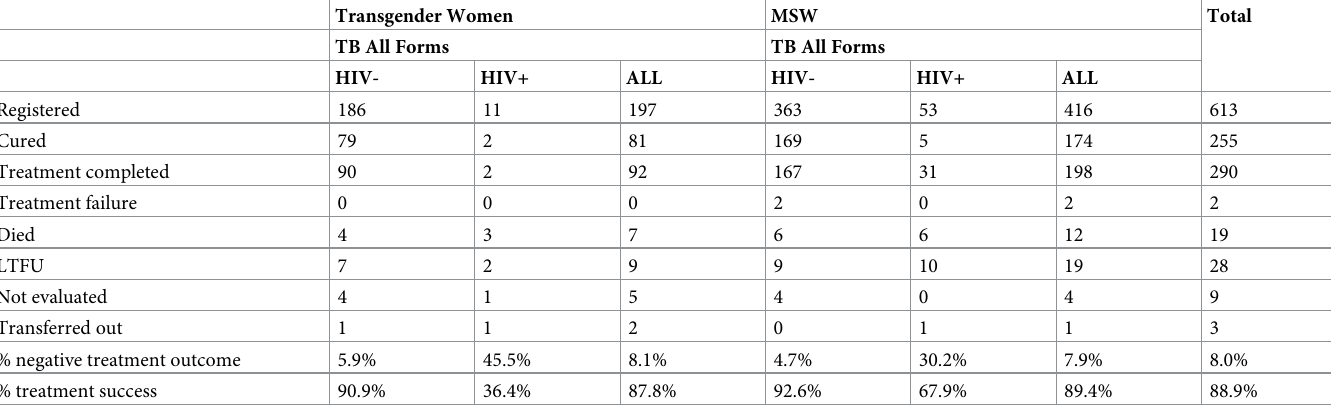
Table 3. TB treatment outcomes for transgender women and male sex workers in Sindh,